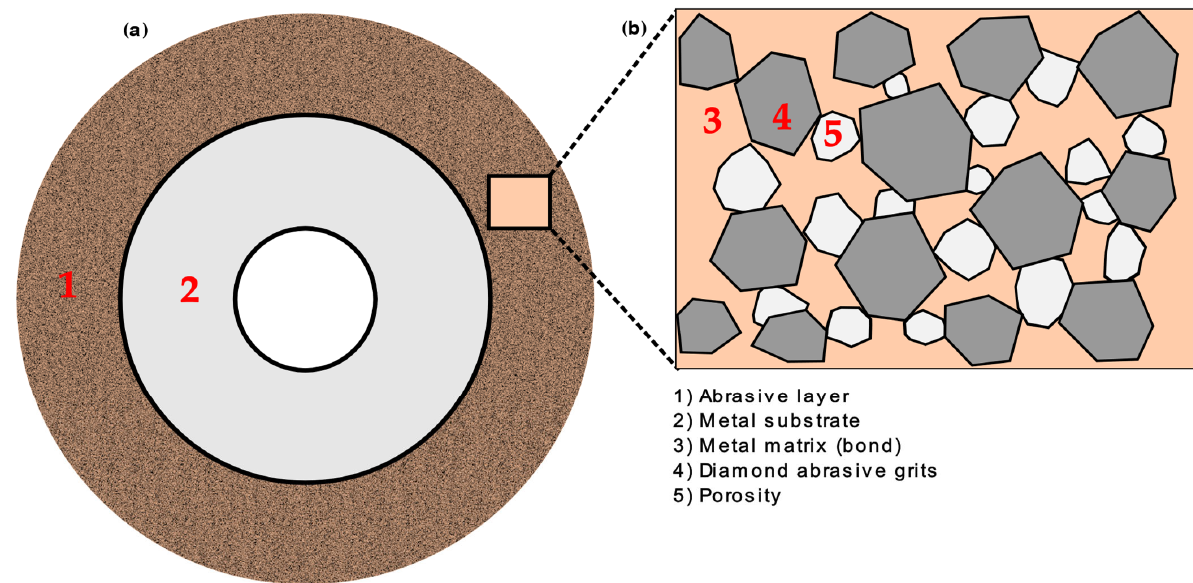
Figure 1. Constitution of a diamond grinding wheel (DGW) ( a ) and its abrasive layer ( b ). Phenomena involved during abrasive machining: the quantification of abrasive power remains a challenging, opening research questions.